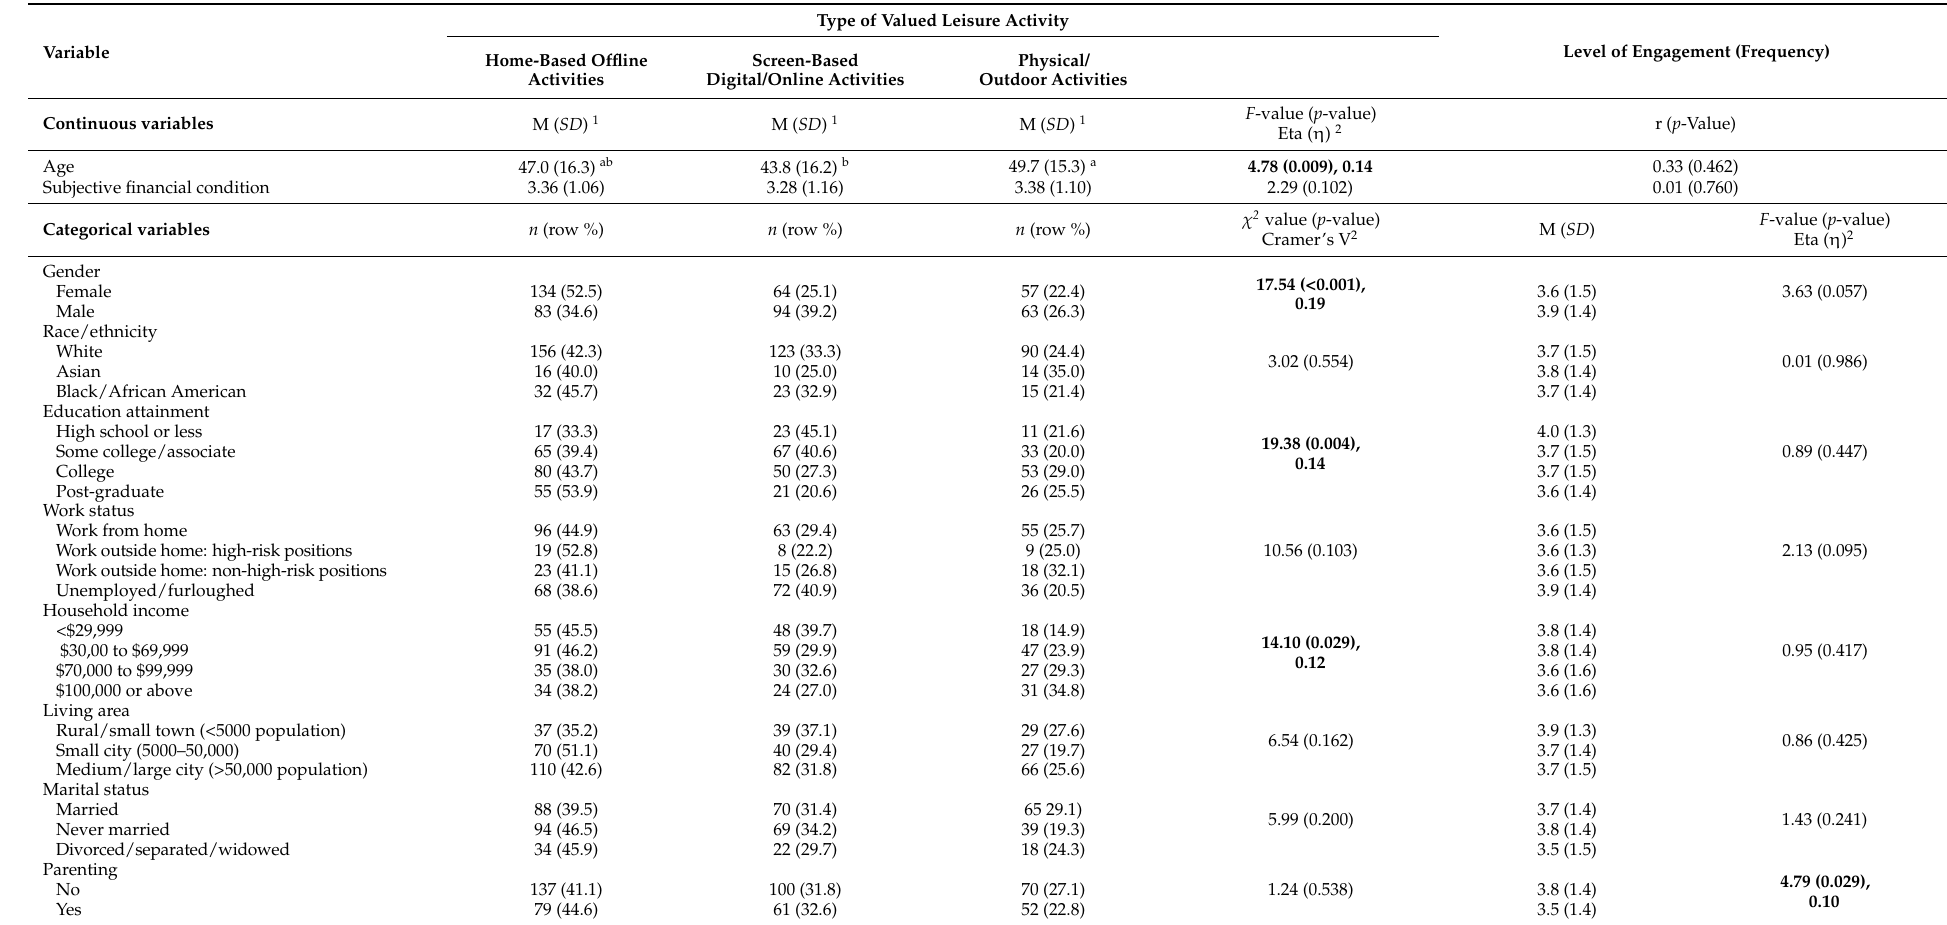
Table 3. Valued leisure activities and the frequency of participation by socio-demographic